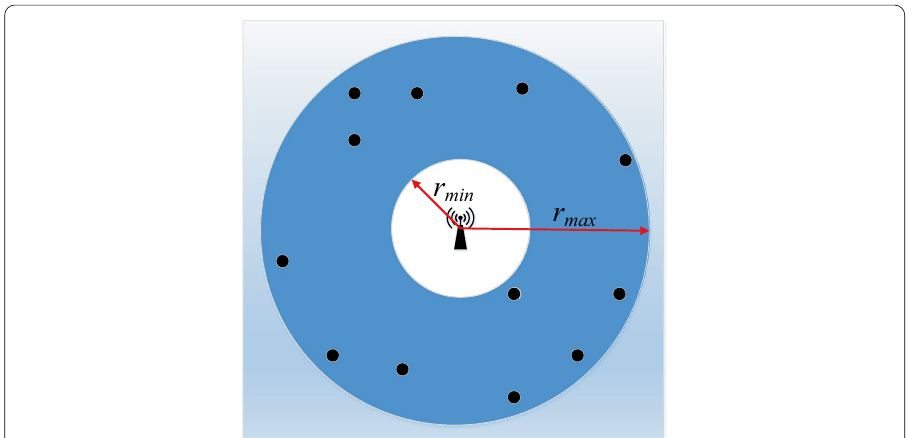
Fig. 1 Illustration of a finite radius network consisting of a receiver with a non‑zero guard